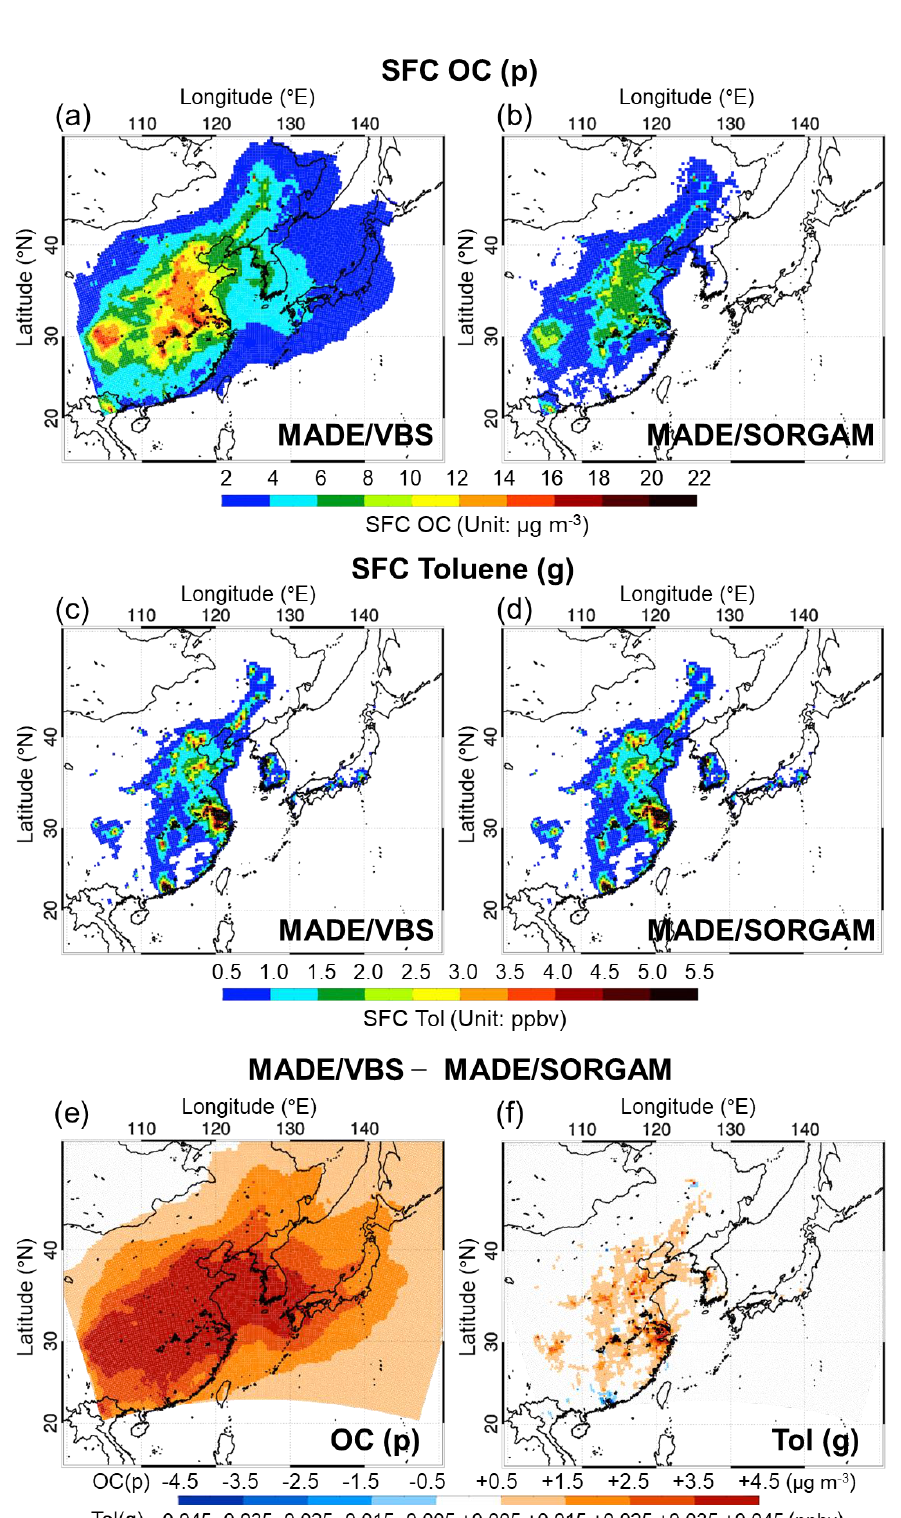
Figure 9. Comparisons of horizontal distributions for organic carbon ( a , b ), toluene gas concentrations ( c , d ), and differences ( e , f ) between two modules, MADE/VBS and MADE/SORGAM, for organic carbon (OC) and toluene, respectively.